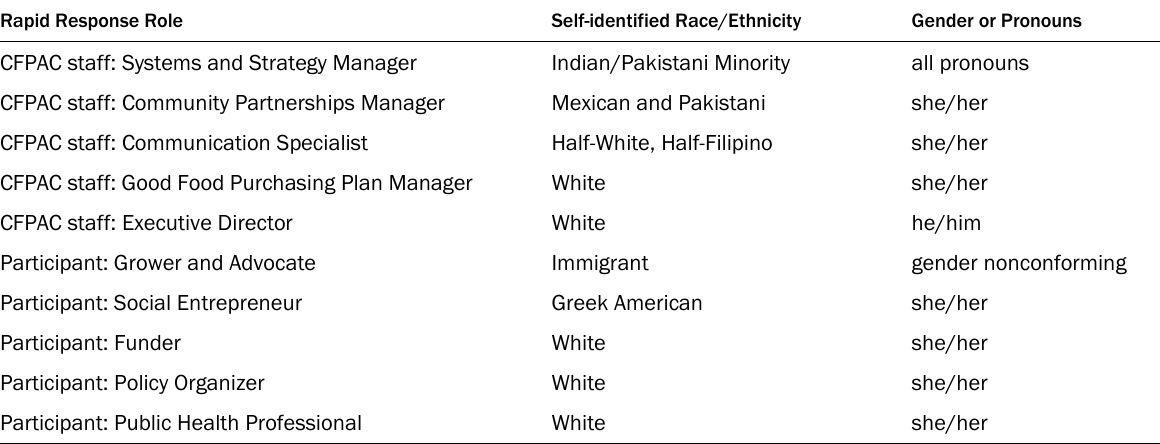
Table 1. Racial/Ethnic and Gender Identities of Interview Participants Rapid Response